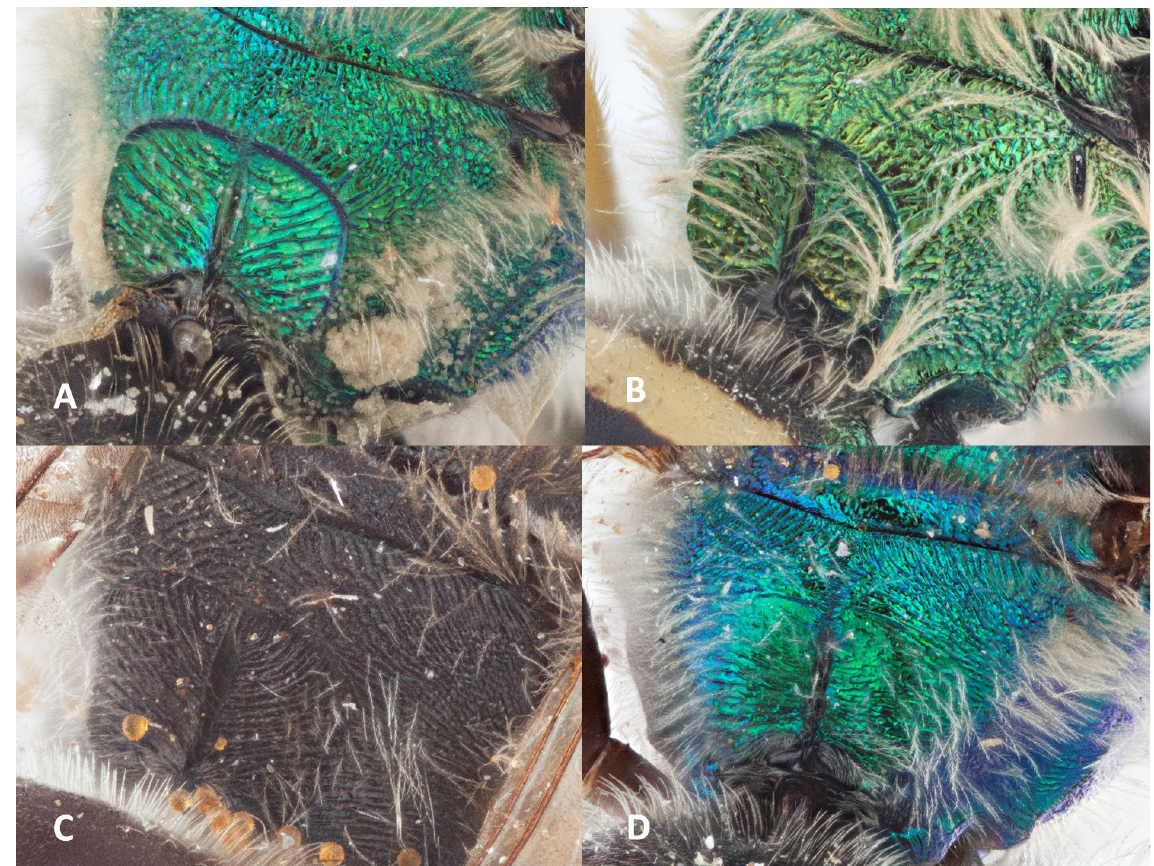
Fig. 8. Propodeum. A–B . Agapostemon virescens (Fabricius, 1775), ♀ (A) and ♂ (B), showing distinctive carina encircling posterior surface. C . Ag. obscuratus Cresson, 1869, ♀ [= Ag. femoralis (Guérin- Méneville, 1844)]. D . Ag. femoralis , ♂, with weak carina that does not encircle posterior